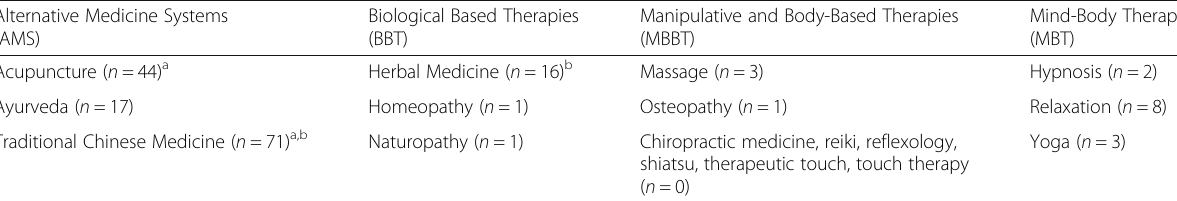
Table 3 Number of Studies by CAM Method ( N = 147) Alternative Medicine Systems (AMS)